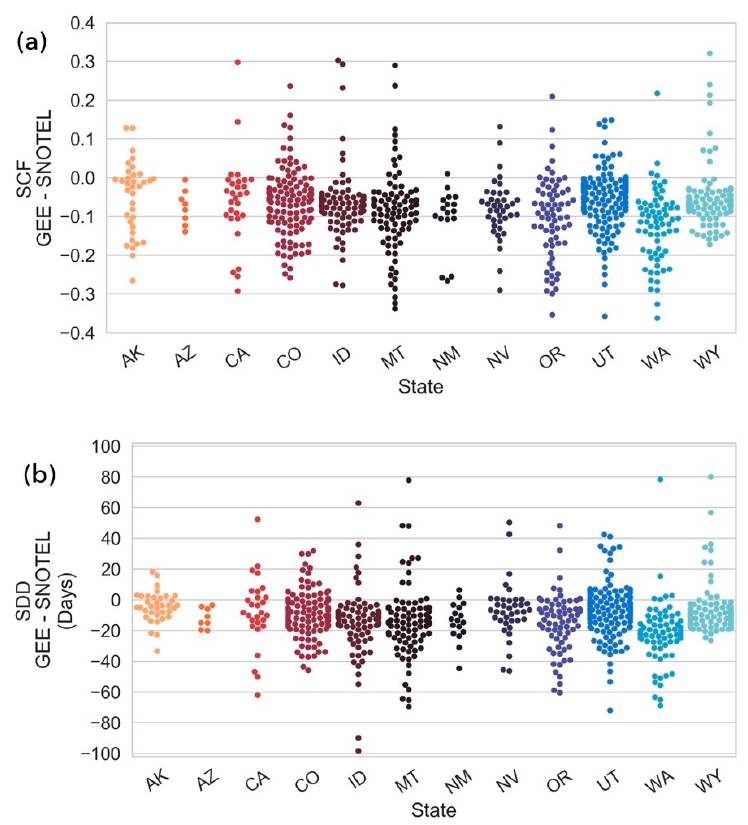
Figure 4. ( a ) Swarmplots of the di ff erence between the GEE-derived snow cover frequency (SCF values at the SNOTEL pixel locations for water years 2001 through 2018. ( b ) Swarmplots of the di ff erence between the GEE-derived snow cover frequency (SDD) values at the SNOTEL pixel locations for water years 2001 through 2018. The swarmplots include the 18-year average at each station. States are listed in alphabetical order as Alaska (AK), Arizona (AZ), California (CA), Colorado (CO), Idaho (ID), Montana (MT), New Mexico (NM), Nevada (NV), Oregon (OR), Utah (UT), Washington (WA), Wyoming (WY). Table 1. Table of SNOTEL derived Snow Cover Frequency (SCF) vs. GEE derived SCF by state ( n = 758). Dataset includes water years 2001 through 2018 for each state. The regional elevation bands were chosen by grouping the data into bands based on the 33rd and 66th elevation quantiles in each state. GEE–SNOTEL Standard Deviation ( σ ) by Regional Elevation Band GEE – SNOTEL RMSE # Stations SNOTEL GEE ( +/ − State SNOTEL vs. Sampled ( +/ − SCF) SCF) (SCF) # GEE(SCF) Alaska 0.1 − 0.03 − 0.04 Arizona 8 California Colorado 113 0.10 − 0.10 − 0.05 −